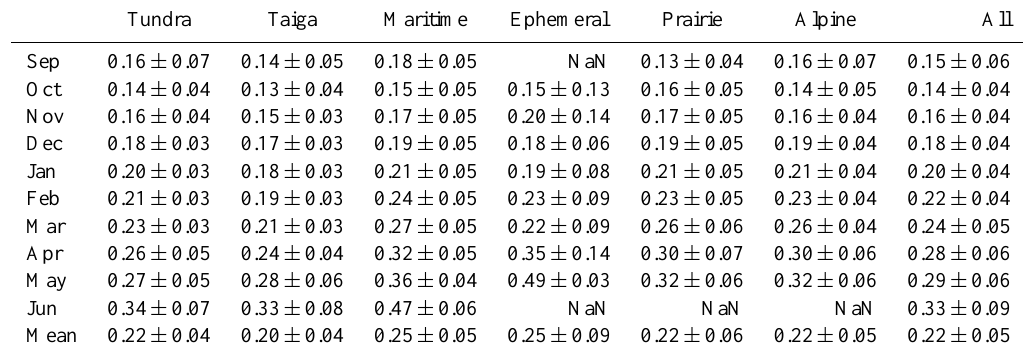
Table 2. Monthly mean snow density of each snow class (gcm − 3 ) . Tundra Taiga Maritime Ephemeral Prairie Alpine All